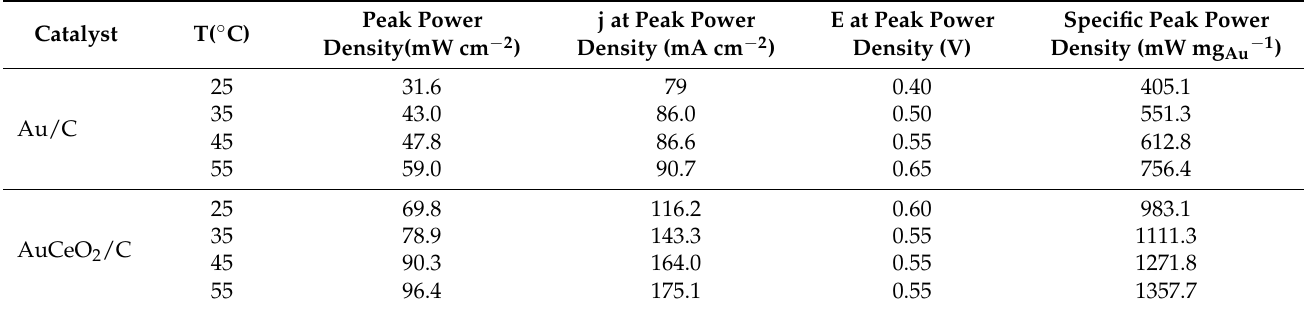
Figure 9. Cell polarization and power density curves were obtained with the employed Au/C ( a ) and AuCeO 2 /C ( b ) catalysts as the anode at different temperatures for the NaBH 4 -H 2 O 2 using the anolyte of 0.05 M BH 4 − in 4 M NaOH and catholyte of 5 M H 2 O 2 in 1.5 M HCl. Table 1. Electrochemical parameters of the NaBH 4 -H 2 O 2 fuel cell at different temperatures employing the Au/C and AuCeO 2 /C catalysts as the anode.